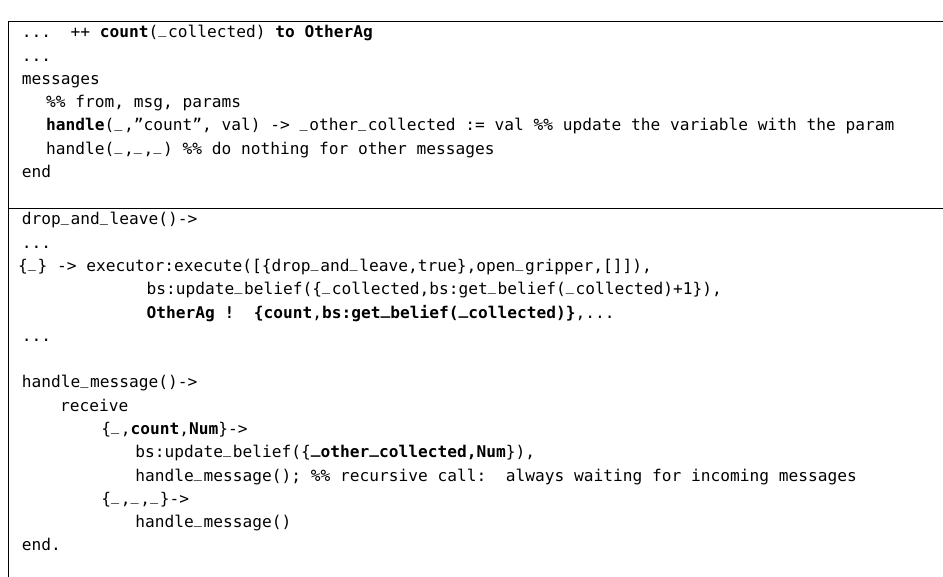
Table 10. TeleoR managing messages (up) and Erlang equivalent